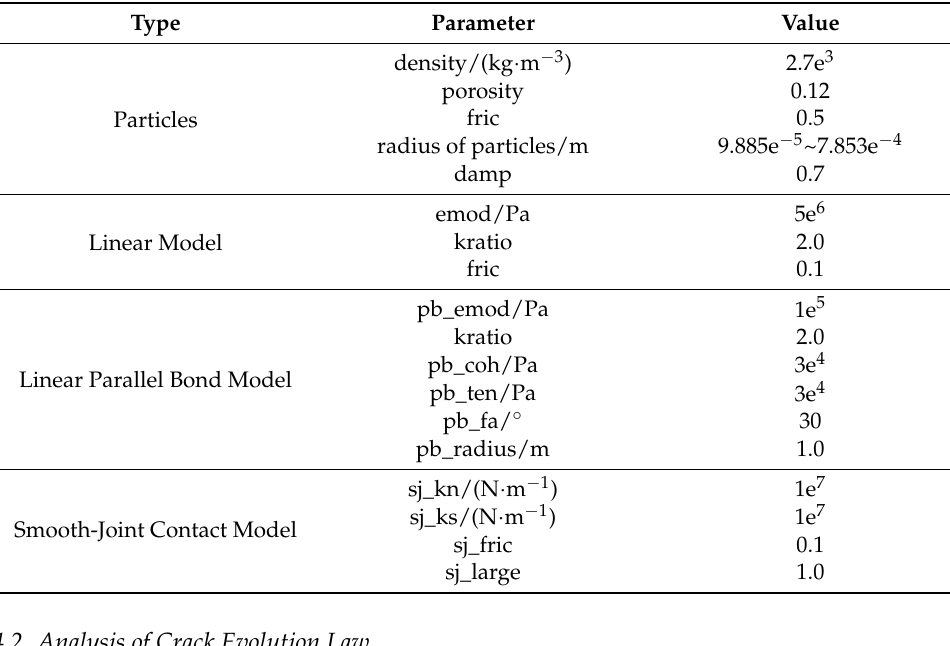
Figure 14.  -  , crack accumulation and crack increment curves: ( a ) N-L; ( b ) 2-L-5.